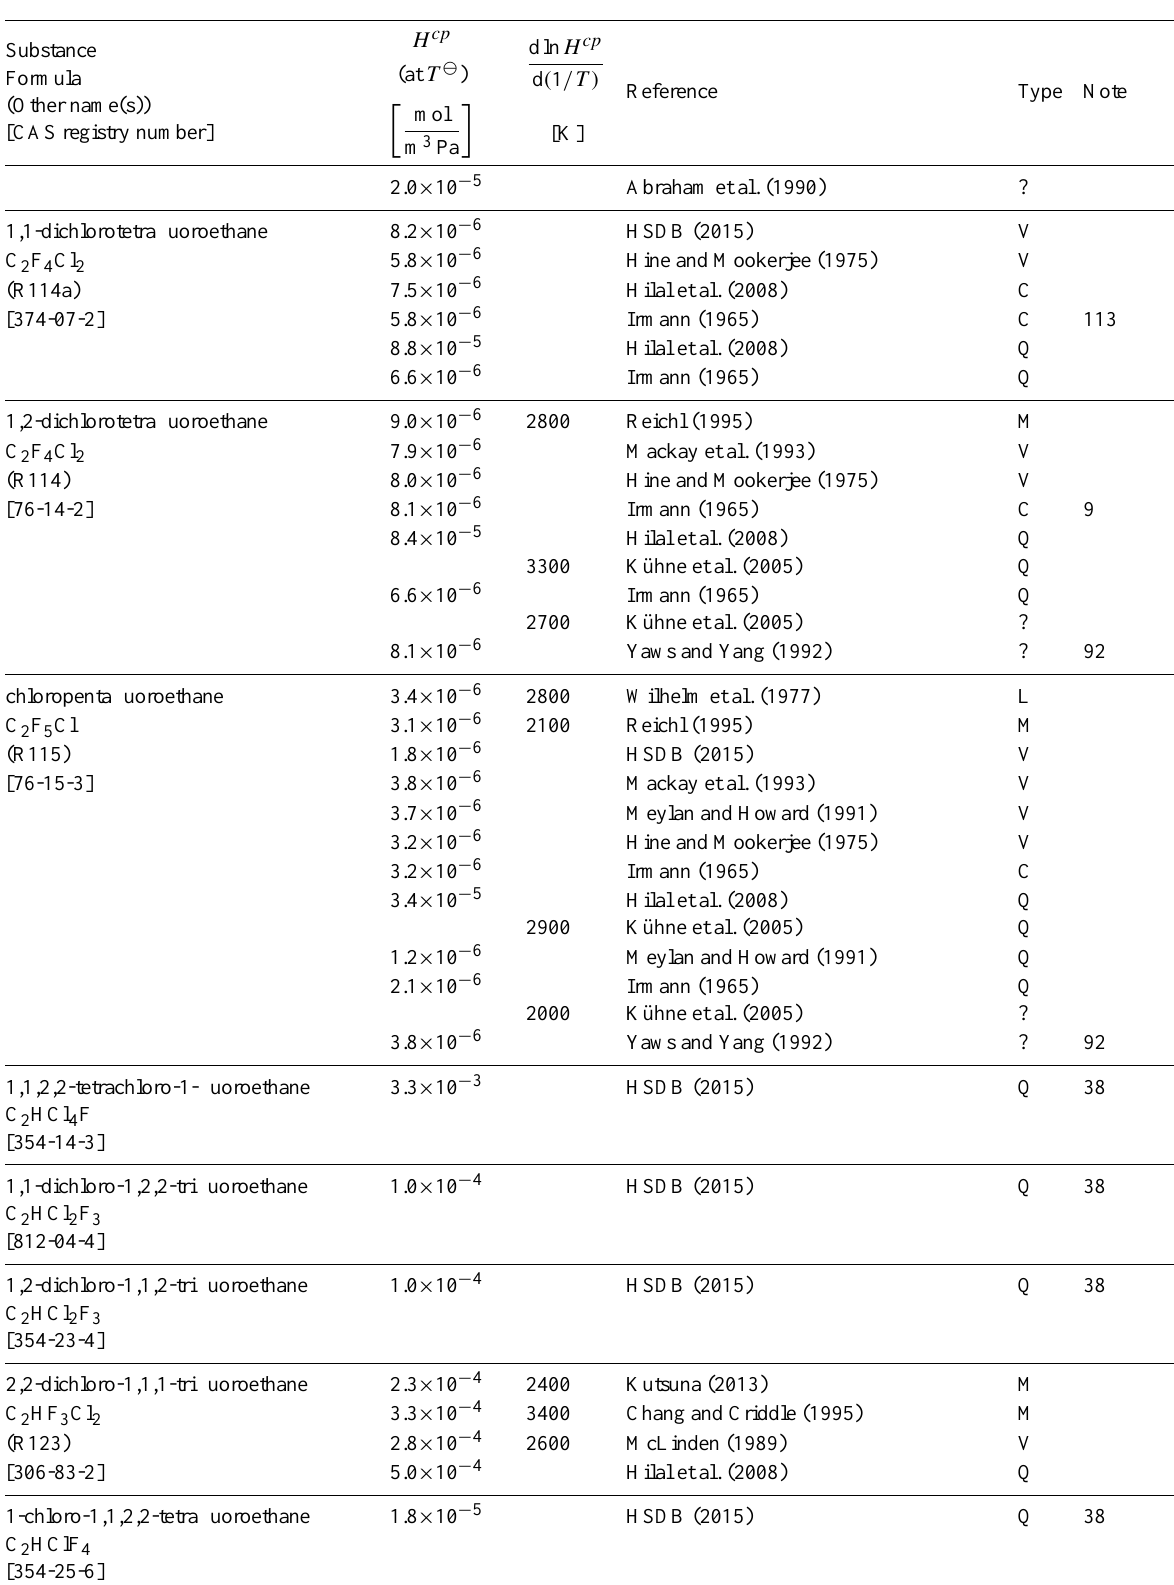
Table 6: Henry’s law constants for water as solvent